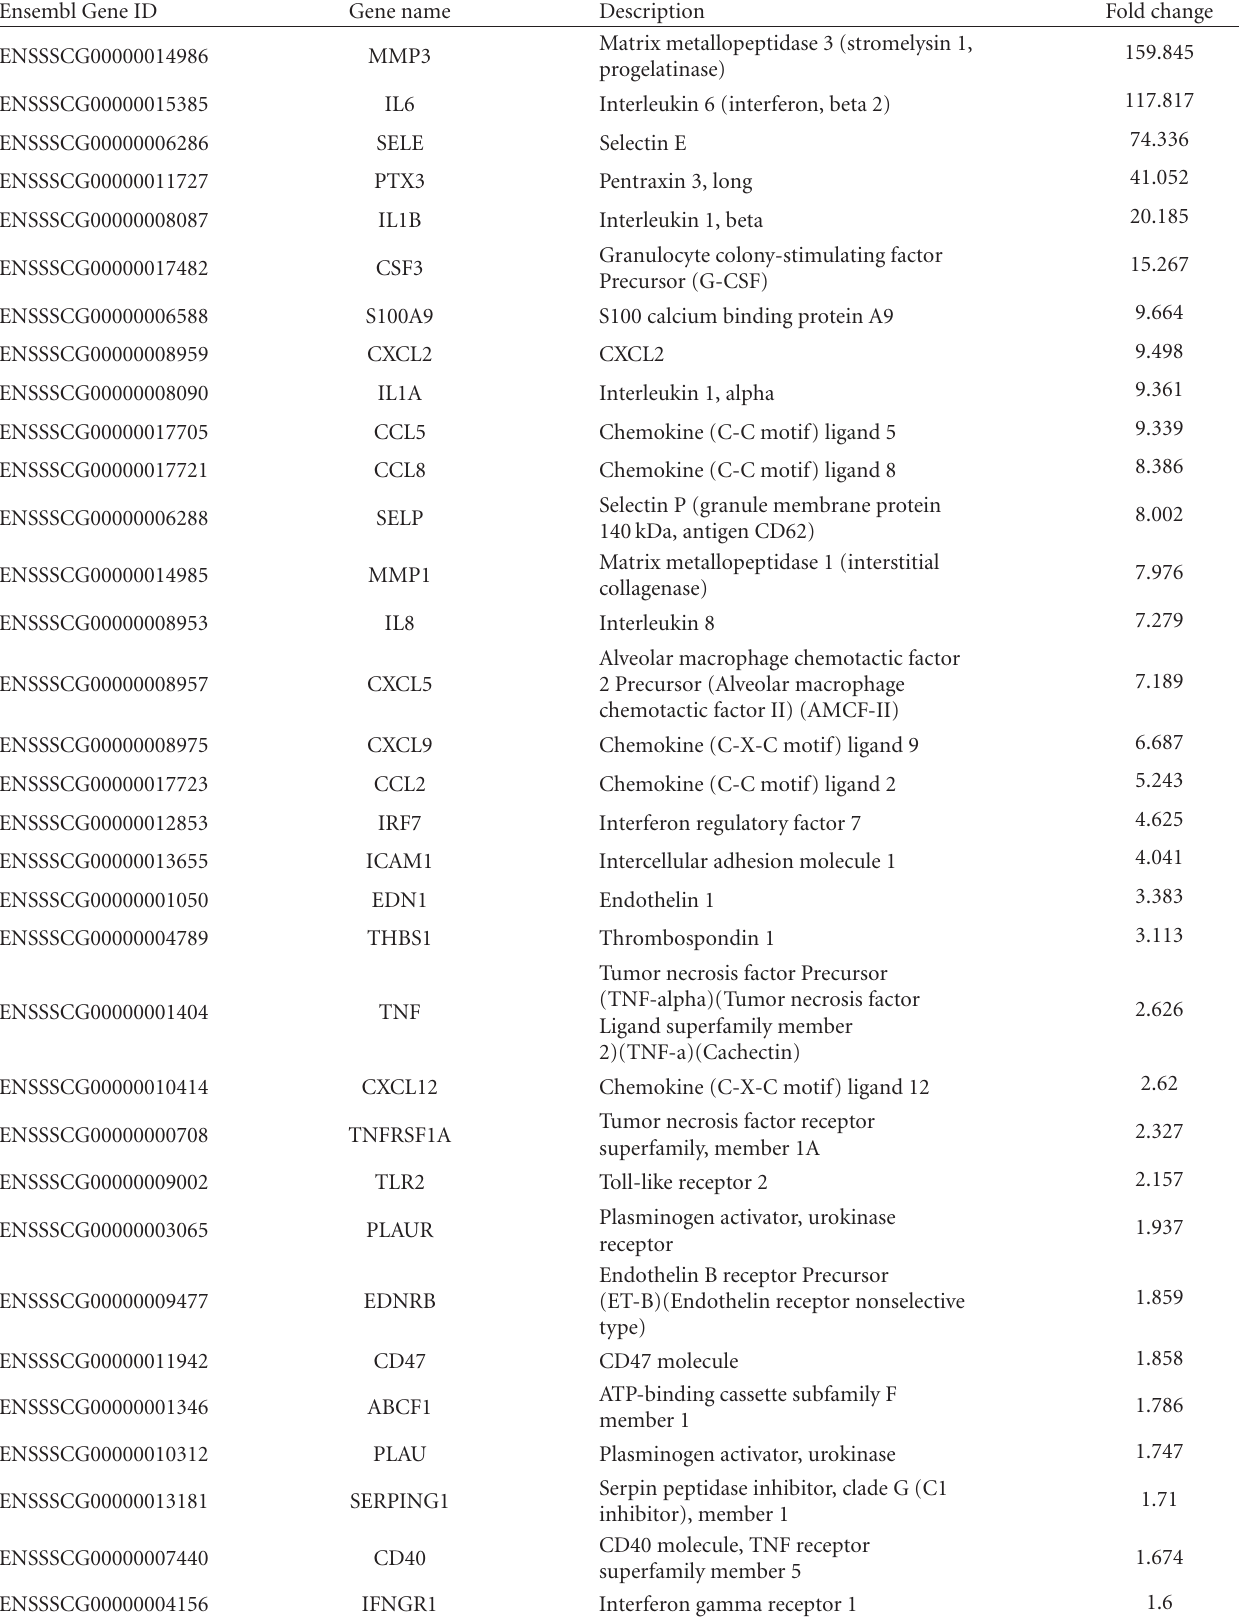
Table 2: Upregulated genes related to inflammation. All genes had a P ≤ 0 .